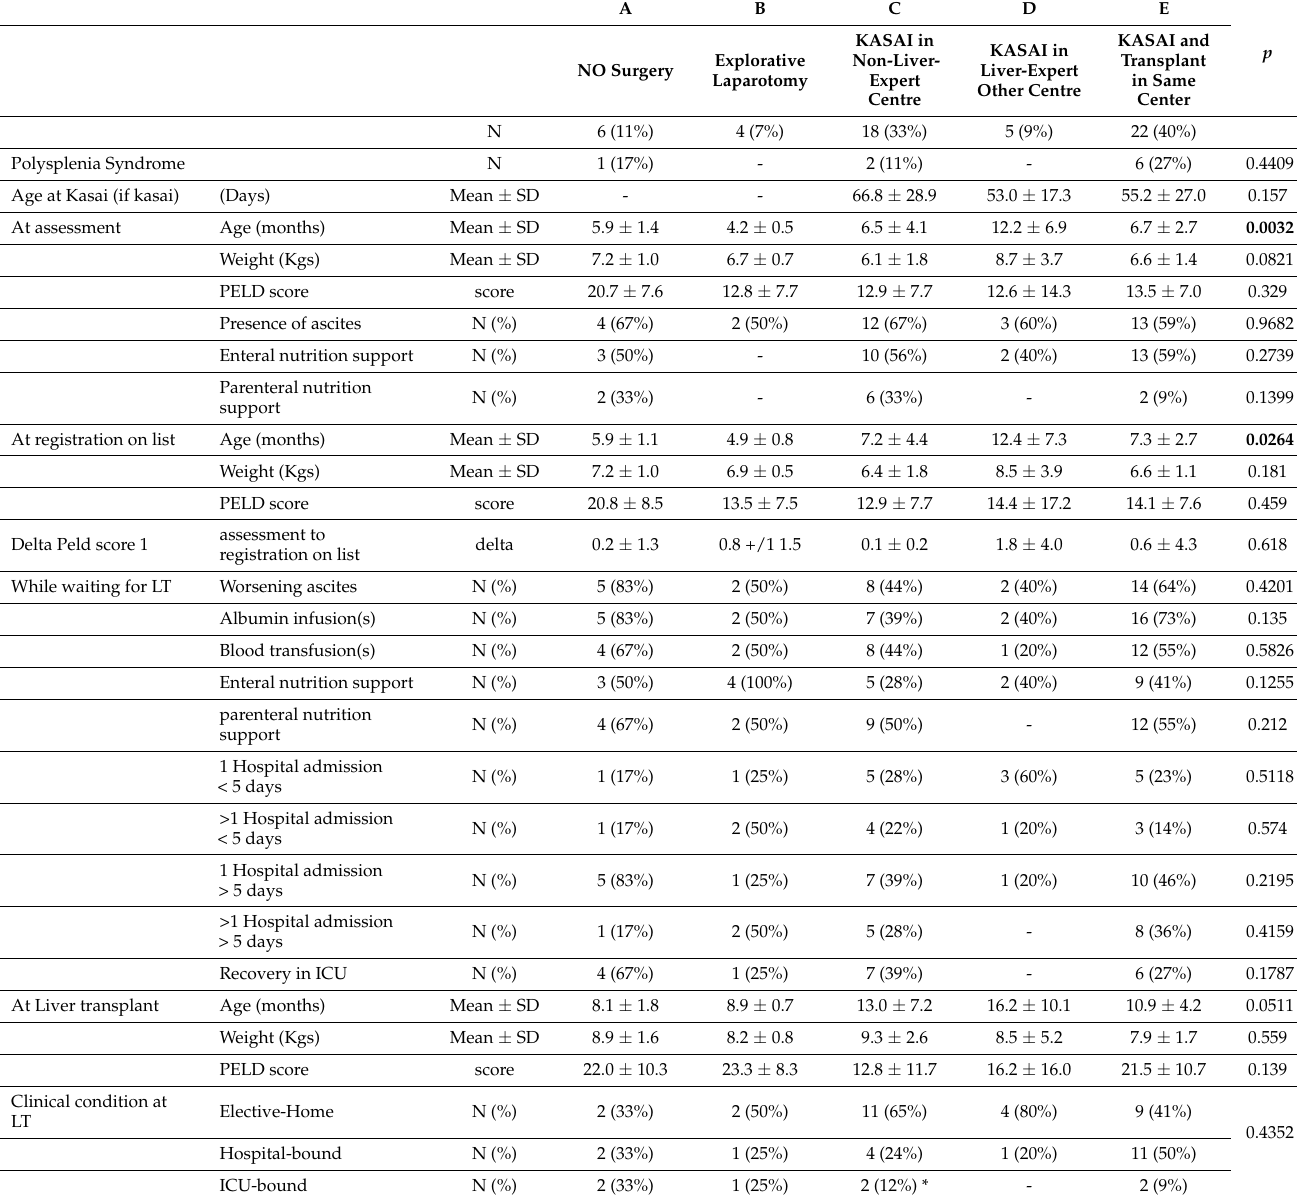
Table 2. USA group: analysis of subgroups as per initial surgery for biliary